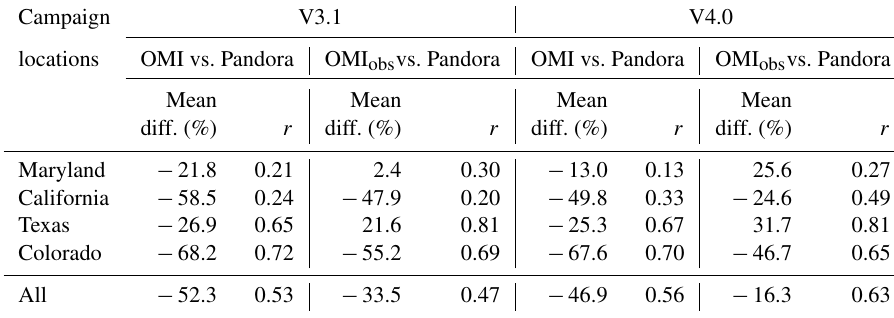
Table 3. Same as Table 2, but with Pandora NO 2 column observations. Campaign V3.1 V4.0 locations OMI vs. Pandora OMI obs vs. Pandora OMI vs. Pandora OMI obs vs. Pandora Mean Mean Mean Mean diff. (%) r diff. (%) r diff. (%) r diff. (%) r − 21.8